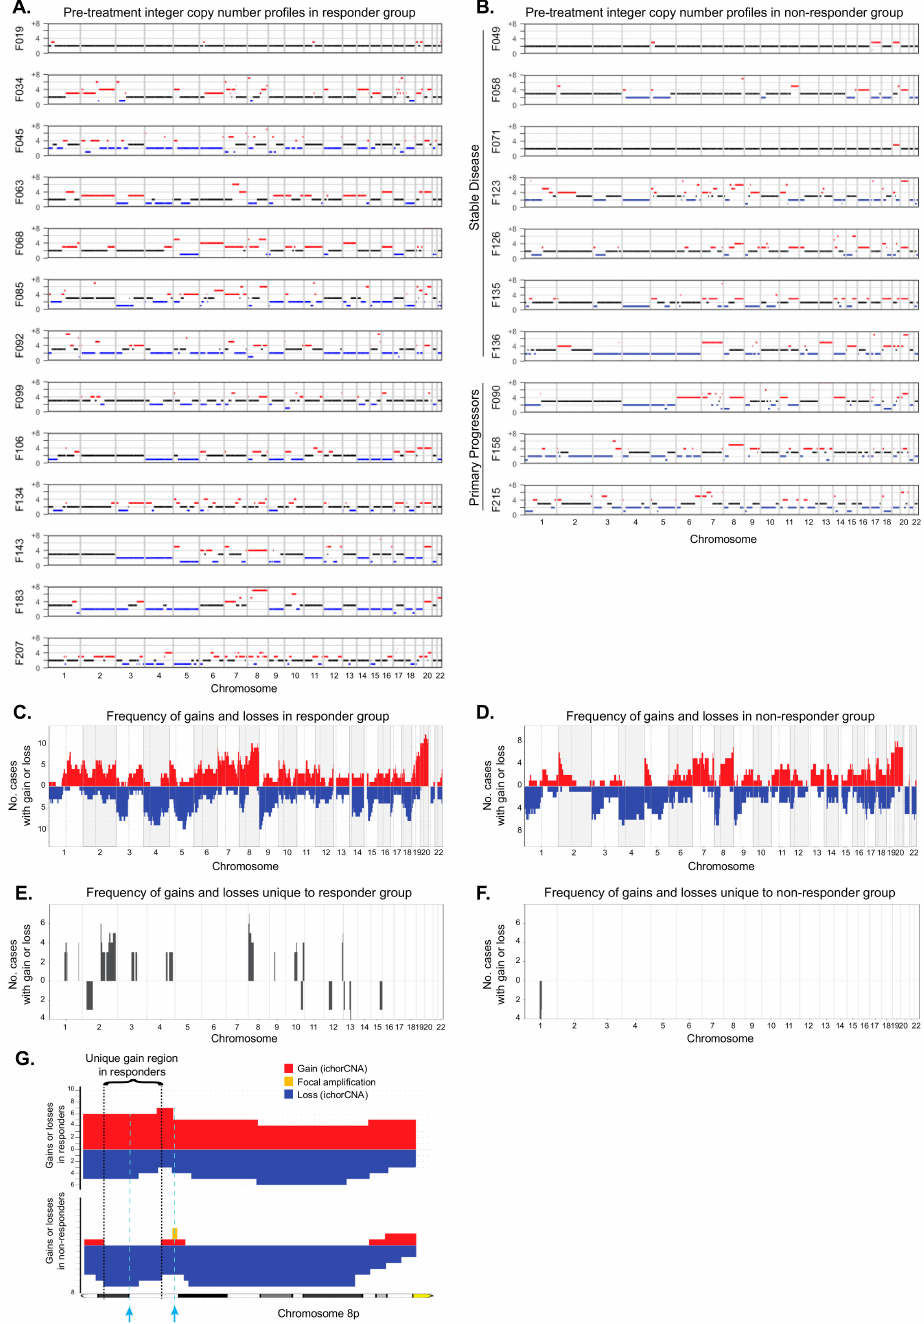
Figure 2. ( A ) Integer copy number profiles (500 kb bins) for pretreatment samples, grouped by subsequent response or ( B ) nonresponse to treatment. Red = gain, blue = loss, and black = ploidy. ( C ) Frequency plots showing the number of cases that show segment gains (red) or losses (blue) in the responder and ( D ) nonresponder groups. ( E ) Frequency plots showing segment gains and losses that are unique to the responder group or ( F ) nonresponder group. ( G ) Frequency of gain (red) and loss (blue) segments of chromosome 8p in the responder group (top) and nonresponder group (bottom). The most frequent region of unique 8p gain is indicated, bounded by dotted lines. The locations of MCPH1 and GATA4 are delineated with a blue dashed line. Two additional nonresponder cases showed focal amplifications (orange) of GATA4 , which were identified with the 50 kb bin method but not the 500 kb ichorCNA